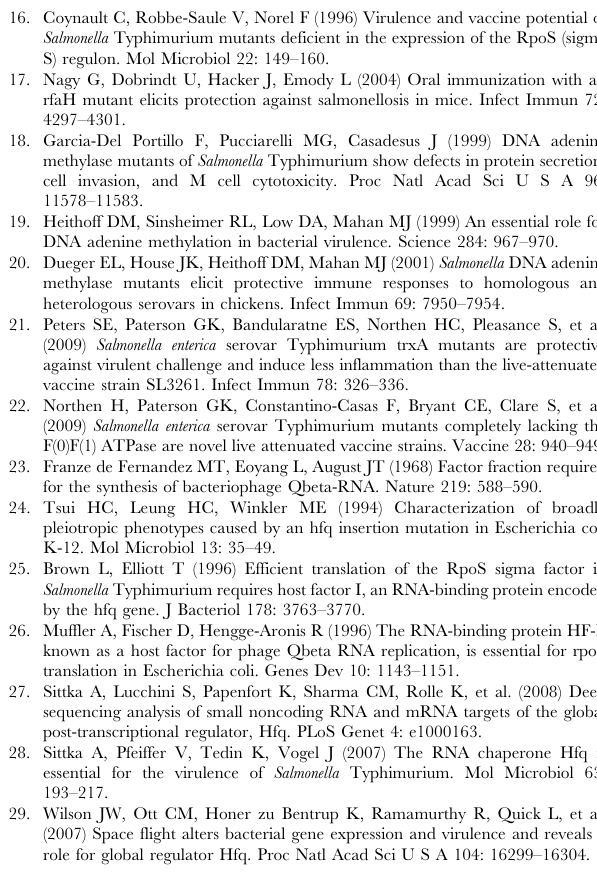
BD Cell-Quest software and represented through dot plot. Each group consisted of 4-5 mice. (TIF) Figure S5 Estimation of the serum IgG and intestinal S-IgA levels 4 weeks after single dose of vaccination. Group of mice were orally given PBS or vaccine strain (10 8 ), serum and intestinal mucus were collected 4 weeks post vaccination. Serum IgG (B&D) and intestinal S-IgA (A&C) antibodies specific for LPS and OMP were measured by ELISA. The samples were assayed in triplicate and the antibody titer is expressed as the absorbance at 450 nm. Result presented is one of two independent experiments. Statistical significance was defined as follows: (*p , 0.05; ** p , 0.005) (Student’s t test). (n=5-6).